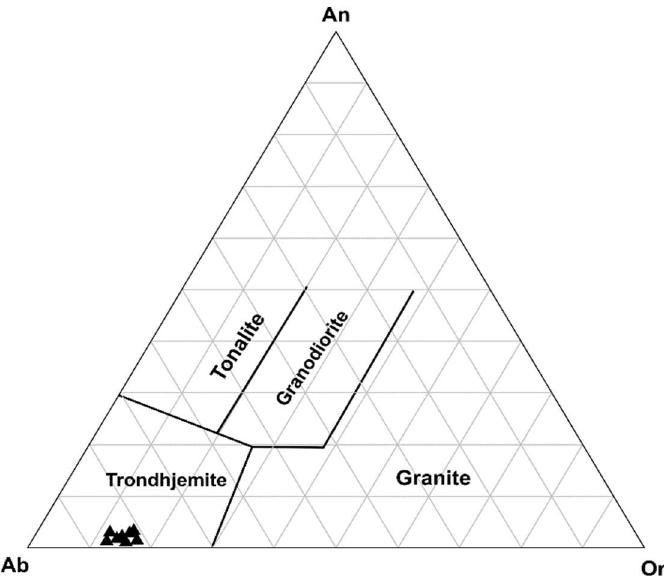
Figure 5. Normative Ab, An, Or diagram showing that the study samples plot in the Trondhjemite field.